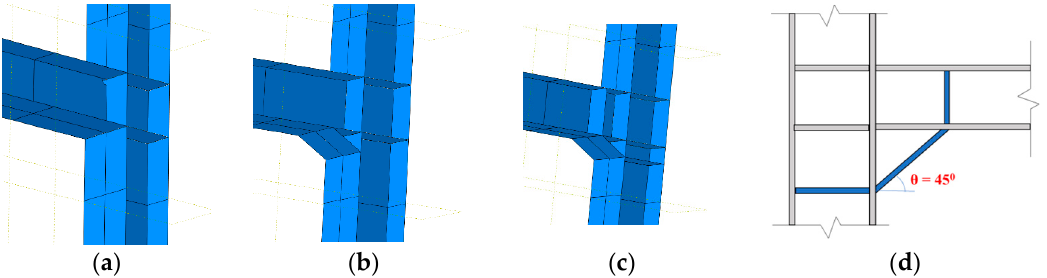
Figure 5. Different details of joint configurations with reinforcement. ( a ) Case 1—Beam-column